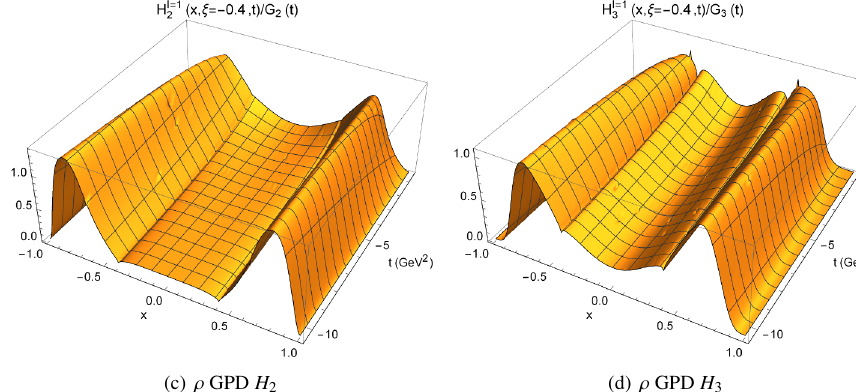
Figure 1. ρ form factors and GPDs with ξ = − 0 .